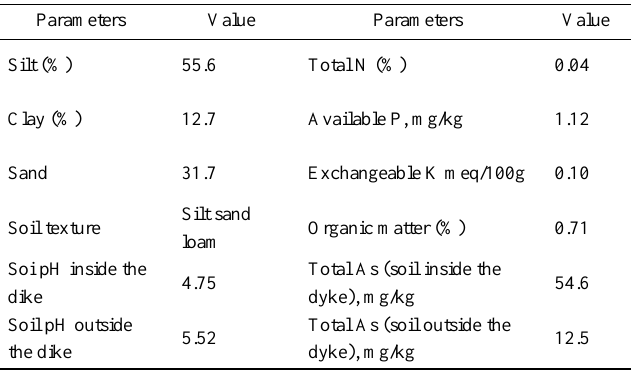
Table 3. Treatments of different irrigation waters and soils on the As